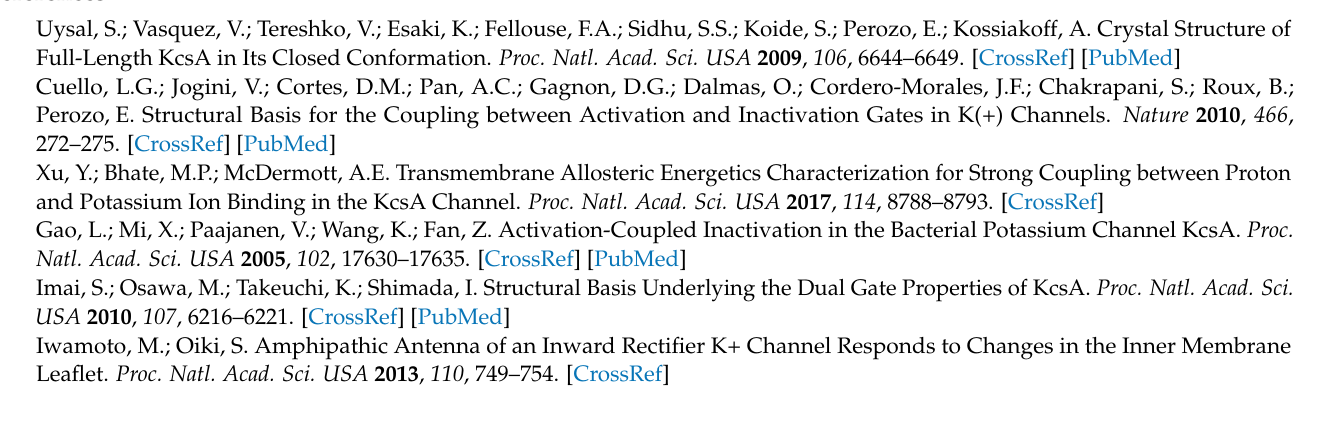
3D HNCA of KcsA proteoliposomes, Figure S9: Planes of inter-residue (i + 1) 3D HNCO of KcsA proteoliposomes, Figure S10: Residue types identified in hCCH-TOCSY data of KcsA, Figure S11: HR-MAS sample radius, Table S1: KcsA 13 C T 2 s, Table S2: 1 H- 13 C HSQC per sample chemical shifts and relative intensities of various species, Table S3: KcsA proteoliposome sample details, and Detailed Materials and Methods